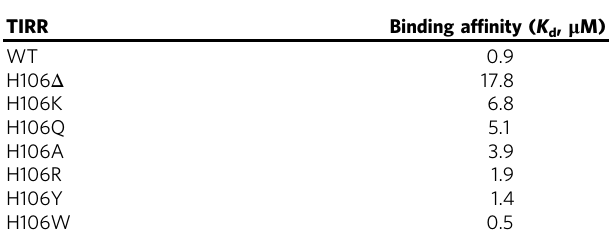
Table 4 Effects of TIRR H106 mutation on binding of